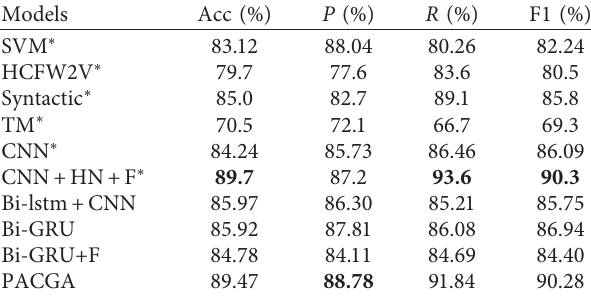
Table 3: Experimental results on Oliners dataset. Best results are in bold. The results with superscript ∗ are imported from the literature [3, 12, 16,